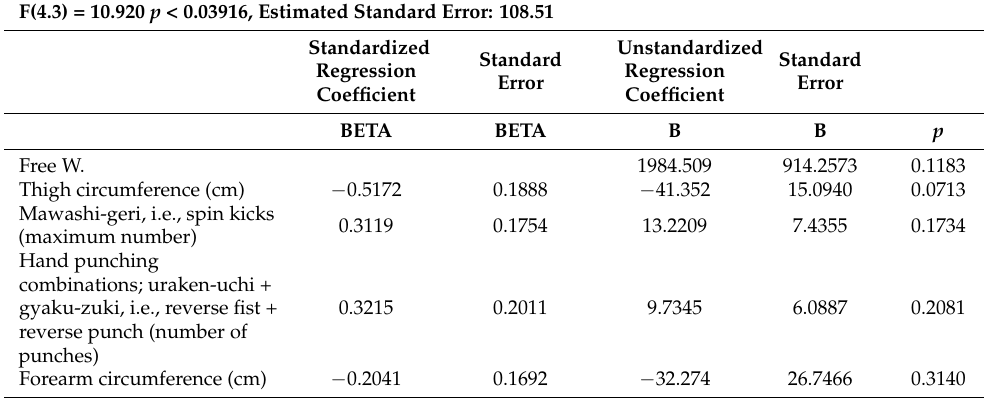
Table 5. Summary details of lambda ridge regression from the 2nd study stage for female participants; dependent variable = ranking points.